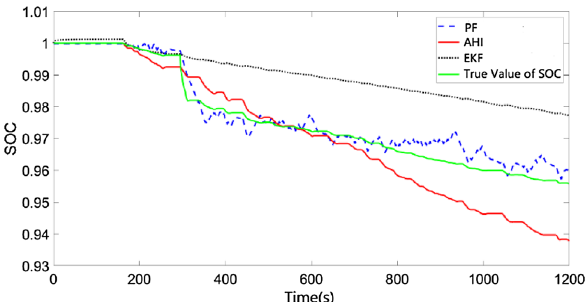
Fig. 2 Comparison of estimated values with initial SOC value of 1